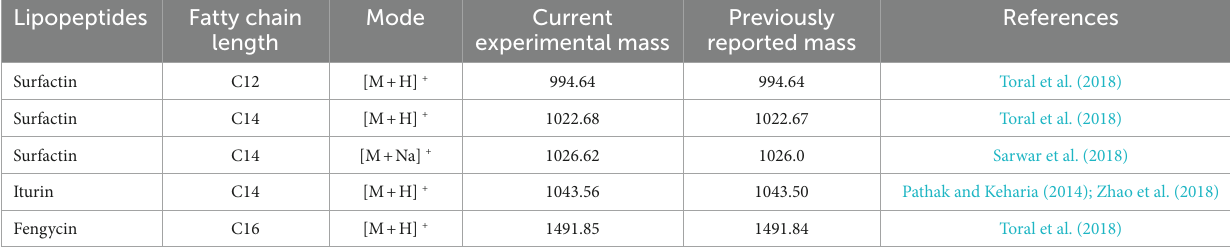
TABLE 3 UPLC-QTOF-MS analysis of LPs produced by